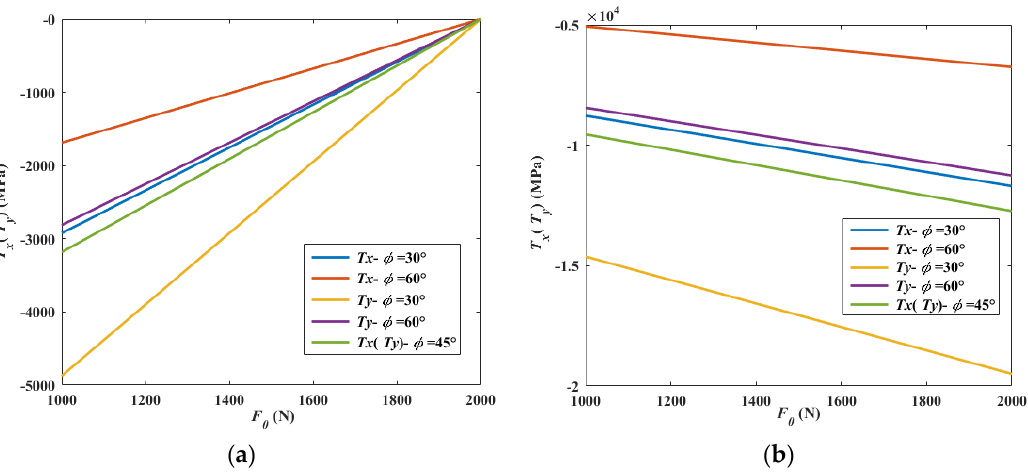
Figure 7. Variation law of T-stress with the amplitude of harmonic dynamic load at different rota- tion angles φ : ( a ) unloading stage at t = 0.005 s; ( b ) loading stage at t = 0.01